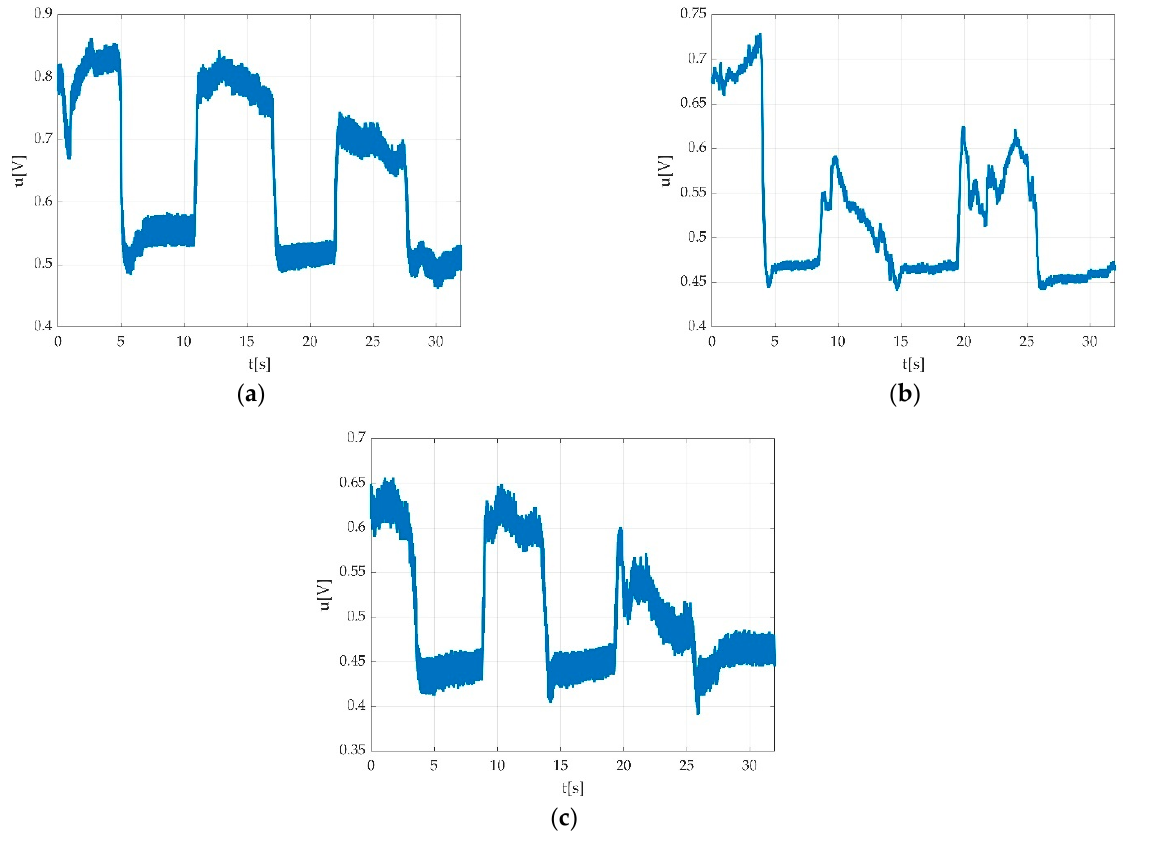
Figure 21. ( a ) Progressive decrement of voltage value due to participant fatigue while plantar flexing the foot; ( b ) invalid measurement due participant discomfort/pain derived from improper fixation of straps; ( c ) invalid measurement due to participant tremor during MVIC.